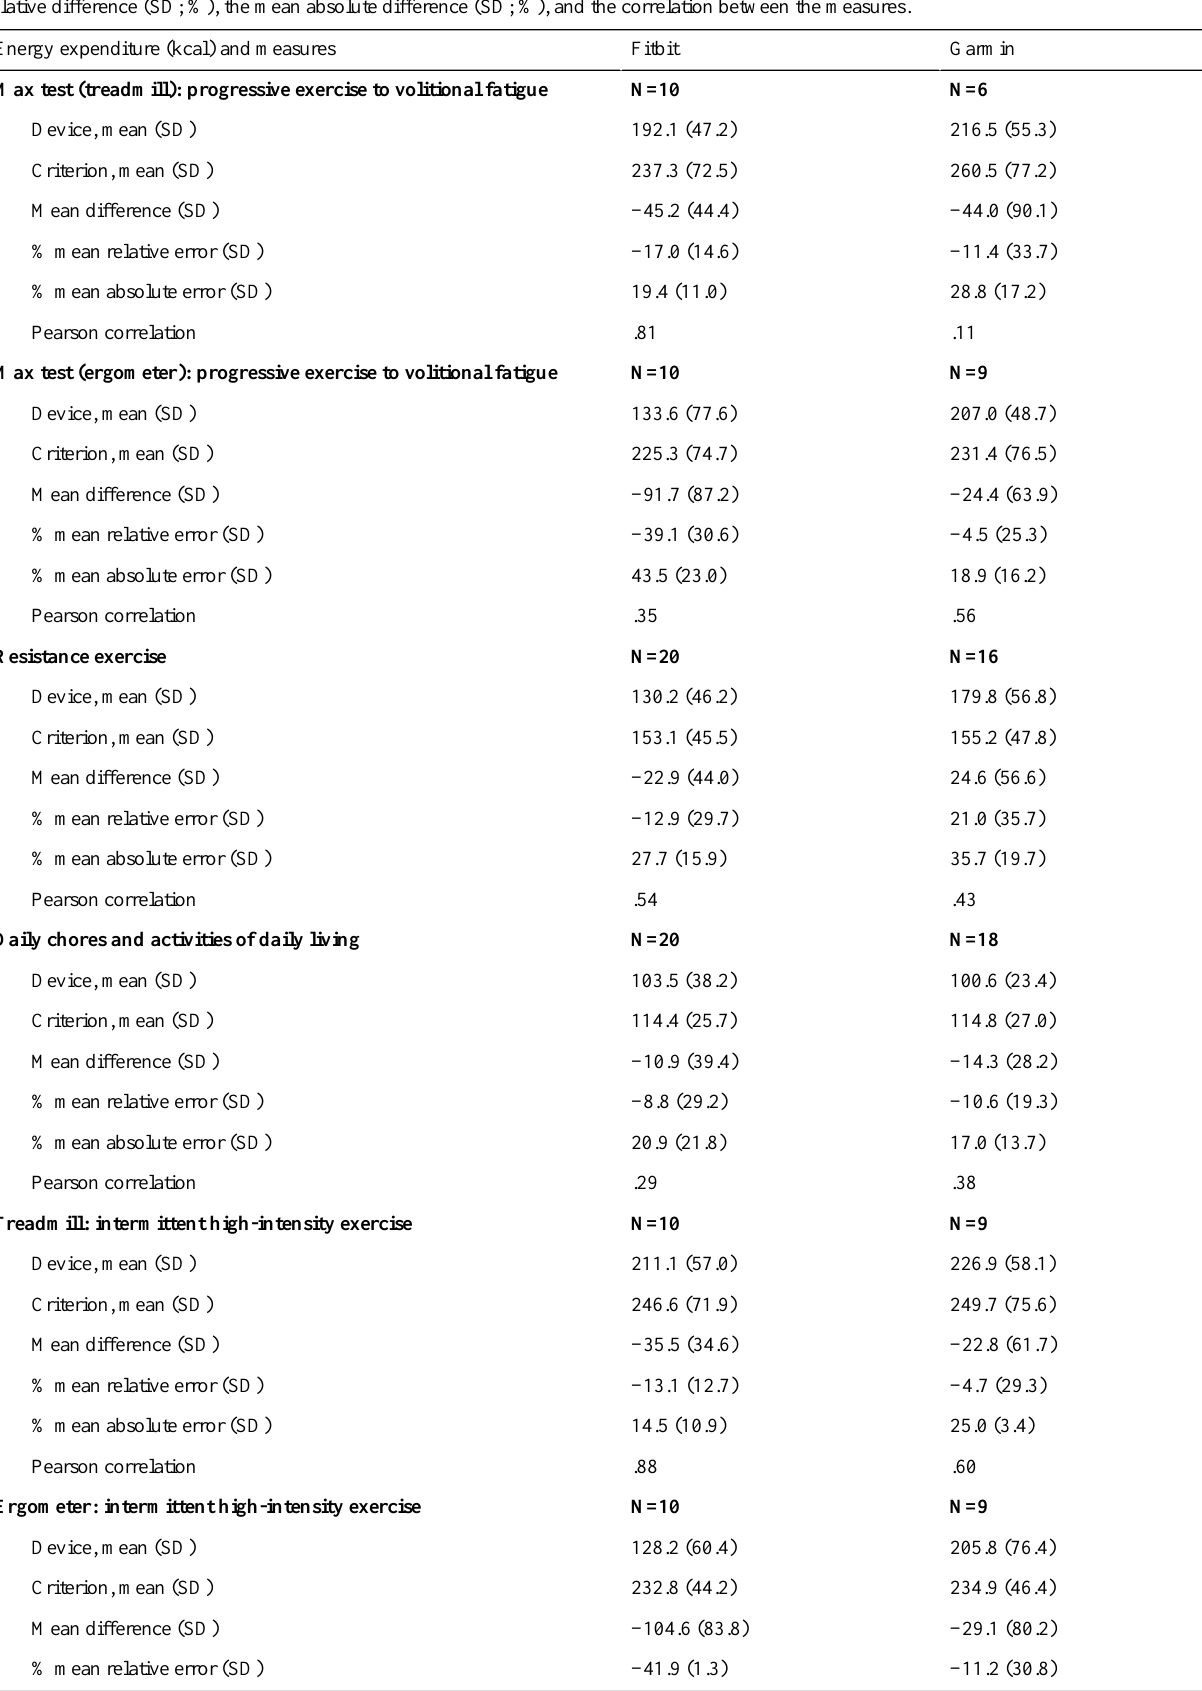
Table 3. Pooled energy expenditure data for the different types of activities undertaken during the study. Data are shown for each activity type. Sample size, mean (SD) of each of the measured device, mean (SD) of the difference between the device measurement and the reference standard, the mean relative difference (SD; %), the mean absolute difference (SD; %), and the correlation between the